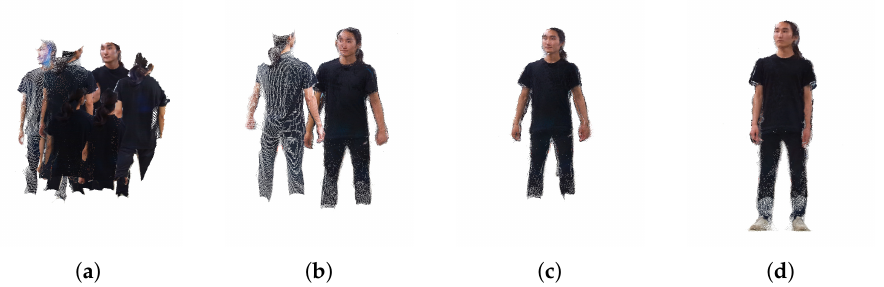
Figure 16. Generated point cloud (human #1) ( a ) before calibration, ( b ) after 15 frames, ( c ) after 21 frames, ( d ) 30